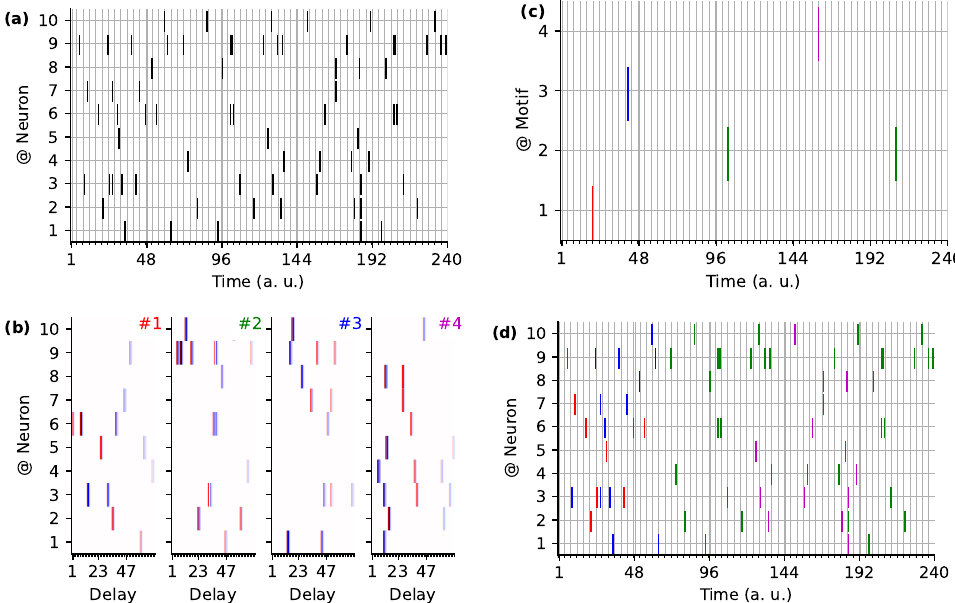
Figure 7. Detecting event-based motifs using spiking neurons with heterogeneous delays. ( a ) Given a generic raster plot defined by a set of spikes occurring on specific neuron addresses and at specific times, one may consider that this information consists of the repeated occurrence of groups of precise spiking motifs. ( b ) The generative model is defined by this set of motifs (here 4 of them) each defined by different weights at heterogeneous delays (red for excitatory, blue for inhibitory). ( c ) Generalizing the core polychrony detection model (see Figure 6), one can define a layer of neurons that detect the identity and timing of these spiking motifs [196]. ( d ) Knowing the results of this detection, one may for illustration purposes highlight them by different colors in the raster plots, showing that in this synthetic example, all spikes are now associated with a